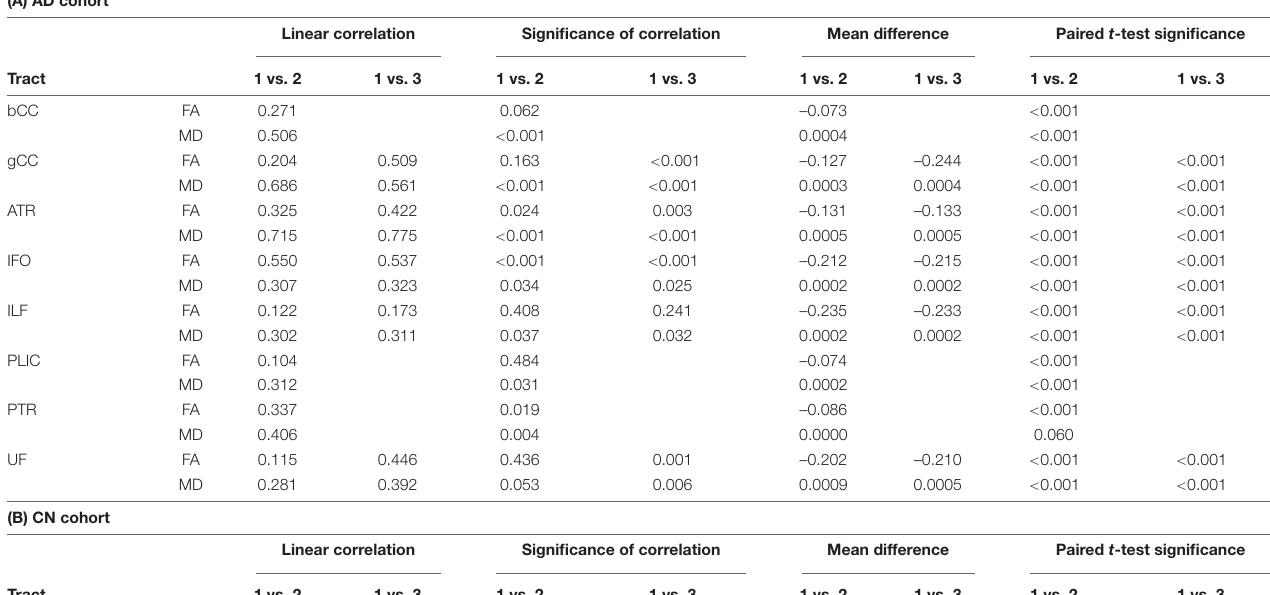
TABLE 3 | Comparison of FA and MD derived by Method 1 against Methods 2 and 3 (ACPC aligned and co-registered) across white matter tracts in the (A) Alzheimer’s disease cohort, (B) cognitively normal cohort, and (C) early mild cognitive impairment cohort. (A) AD